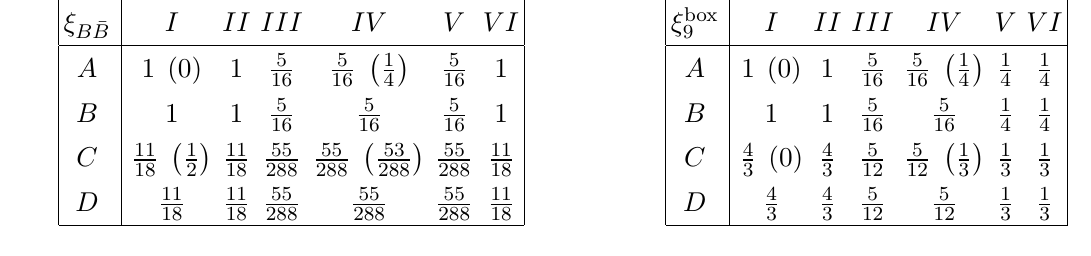
Table 3 . Group factor for B s (cid:0) B s mixing and C box brackets are for the case of Majorana fermions or real